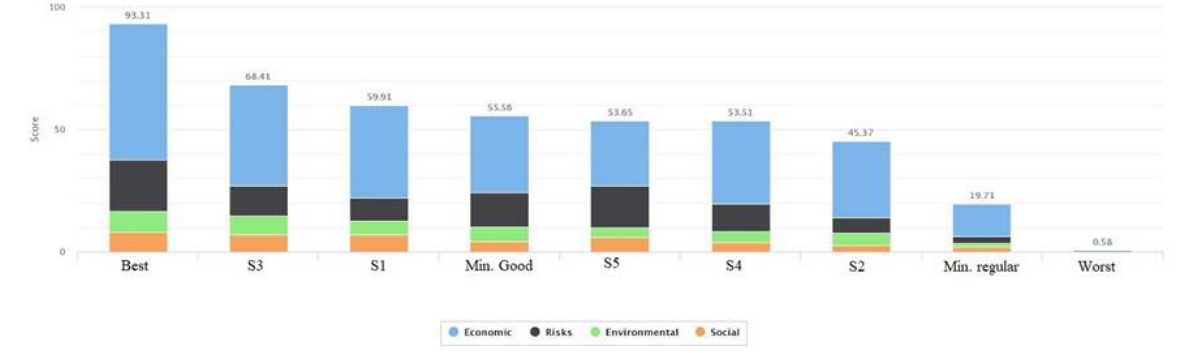
Figure 9. Criteria contribution and supplier sorting by an extended FlowSort.